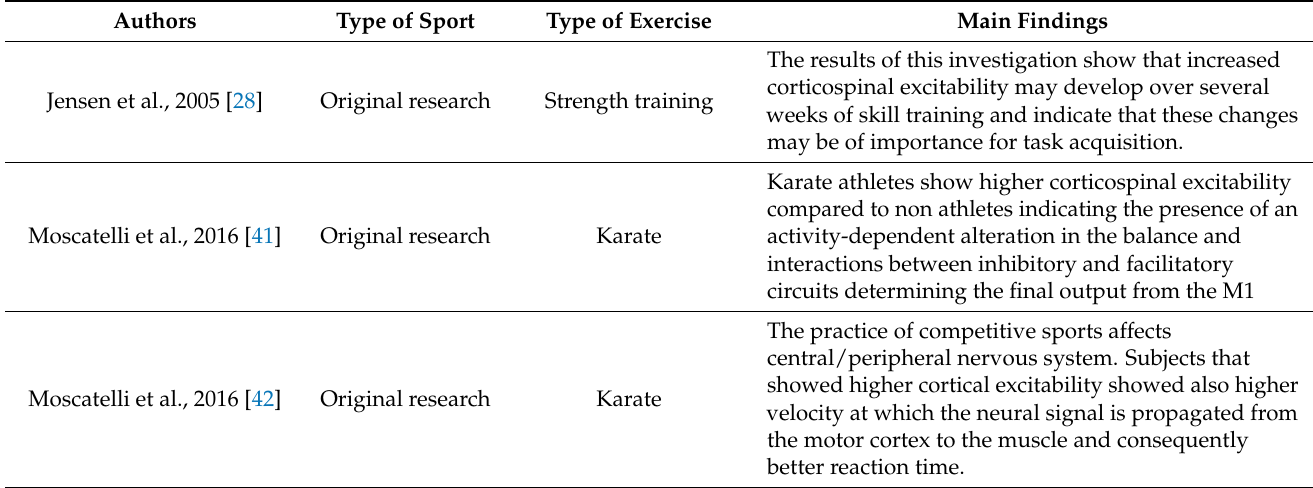
Table 1. TMS in physical exercise. In this table are sreported the research performed to investigated the relationship between cortical excitability and physical